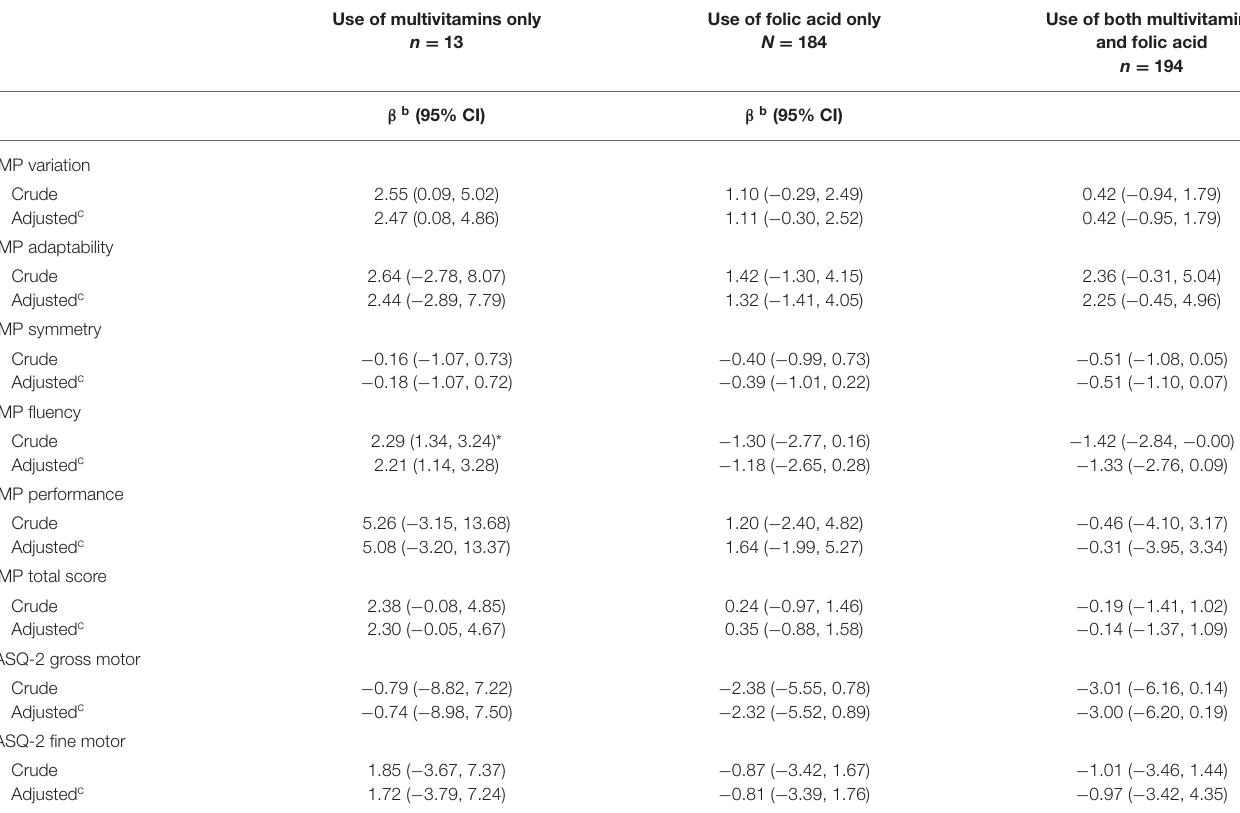
TABLE 4 | Dose-response associations of folic acid use with motor function #